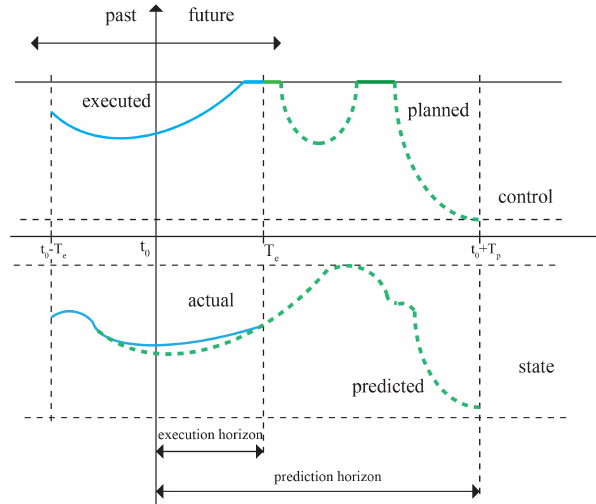
Figure 9. Basic principle of